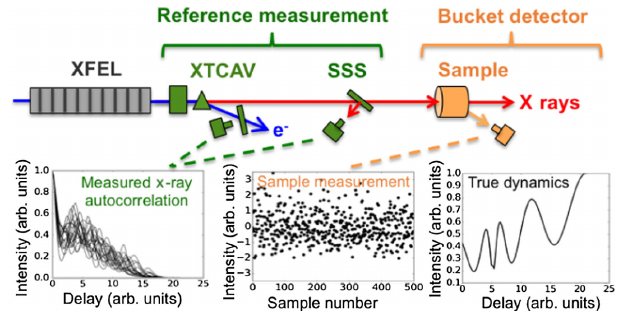
FIG. 2. Schematic of the general PPGI scheme. Time- (e.g., XTCAV) or frequency-domain [e.g., single-shot spectrometer (SSS)] measurements record the autocorrelation on a shot-by- shot basis upstream of the sample (lower left). In the terminology of ghost imaging, these reference measurements record the fluctuations incident on the sample. “ Bucket ” measurements downstream of the sample, e.g., photoelectron counts, contain no explicit time information (lower middle). Correlating shot-to-shot variations in sample measurements with the corresponding measured SASE fluctuations reveals the true sample dynamics (lower